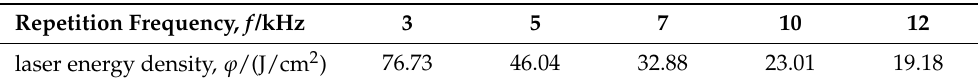
Table 4. The laser energy density corresponding to different laser repetition frequencies when the laser power is 14